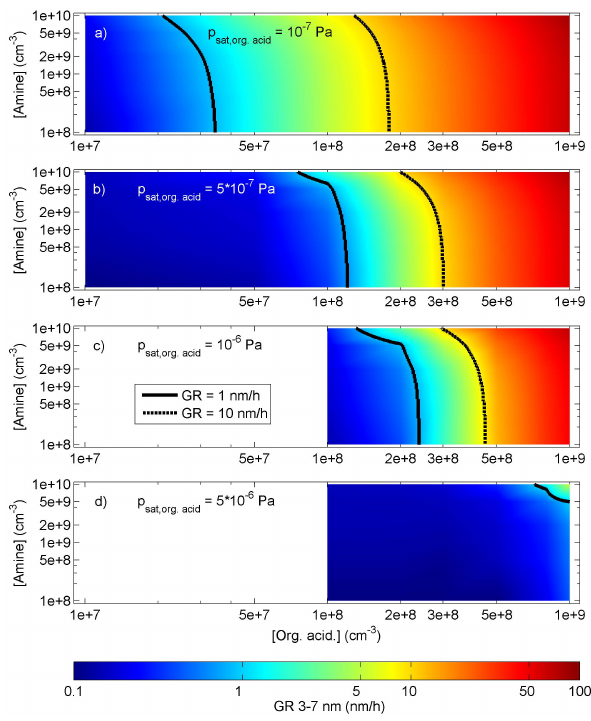
Fig. 2. Growth rate of 3–7nm particles as a function of organic acid and amine concentration predicted, assuming saturation vapour pressure of organic acid to be (a) 1 × 10 − 7 Pa, (b) 5 × 10 − 7 Pa, (c) 1 × 10 − 6 Pa and (d) 5 × 10 − 6 Pa. Concentrations of sulfuric acid (10 6 cm − 3 ) and ammonia (10 9 cm − 3 ) , RH (40%) and temper- ature (283.15K) were set to base case values presented in Table 2, and properties of organic acid 1 (Table 1) were used.